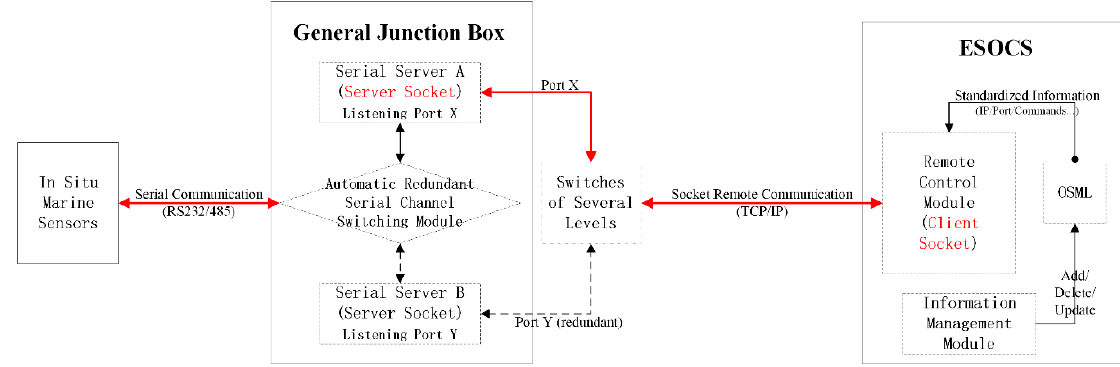
Figure 6. Plug and Play Enablement.